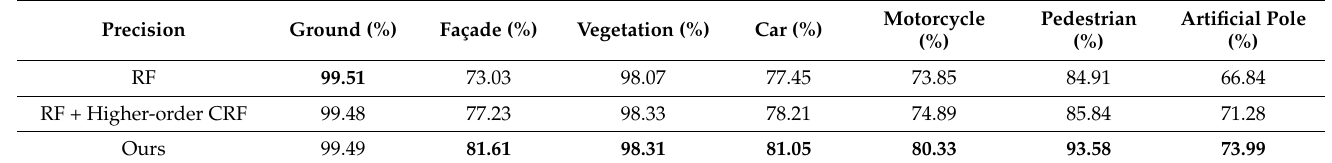
Table 11. Precision of the proposed method in different steps in the Wuhan University dataset. Precision